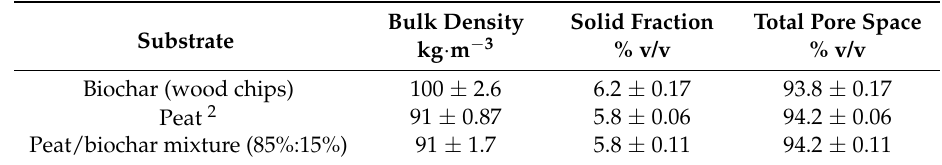
Table 4. Bulk density and volumetric contribution of solid particles and pores in peat, biochar and peat-biochar mixture 1